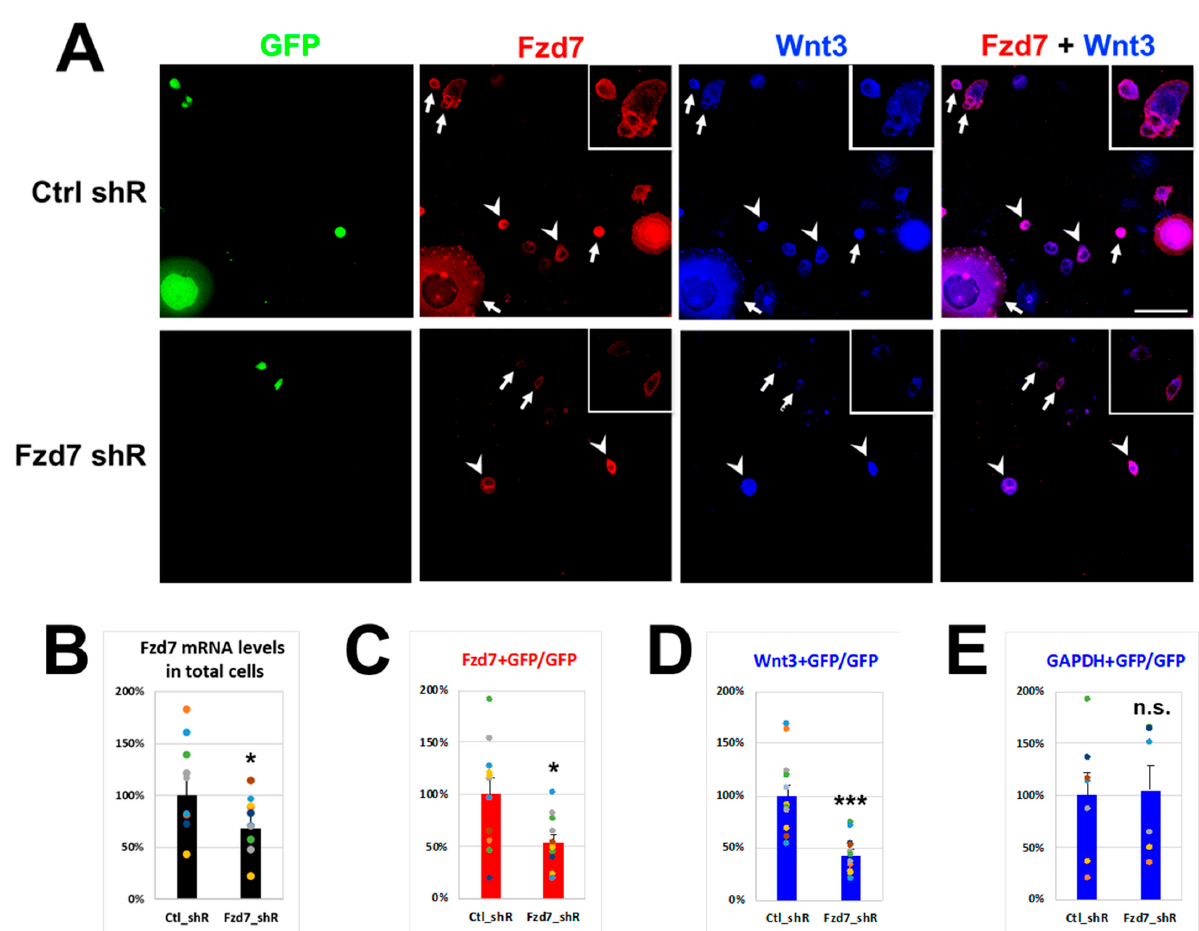
Figure 3. Interaction between Wnt3 and Fzd7 in neuroblastoma N2a cells. ( A ). IHC for GFP (green), Fzd7 (red), and Wnt3 (blue) in N2a cells after 3 days of each shRNA transfection containing GFP marker ( Ctrl or Fzd7 shRNA) and following 4 h of Wnt3 (100 ng/mL) treatment ( n = 3 separate transfections). Arrow: shRNA-transfected GFP cells (insert: higher magnification image); arrowhead: non-transfected cells; scale bar: 100 µm. ( B ). Fzd7 mRNA expression levels in total N2a cells determined by qRT-PCR ( n = 10 repeats) when IHC was performed in A . Data of Fzd7 shRNA were normalized to Gapdh and then to Ctrl shRNA (100%). ( C – E ). Quantification of Fzd7 ( C ), Wnt3 ( D ), Gapdh ( E )-positive cells among total GFP cells (251–356 counted), normalized to the Ctrl shRNA ( n = 6–12 repeats). Data represent the mean and SEM. Statistics: Student’s t-test; *: p < 0.05; ***: p < 0.005; n.s.: not significant.